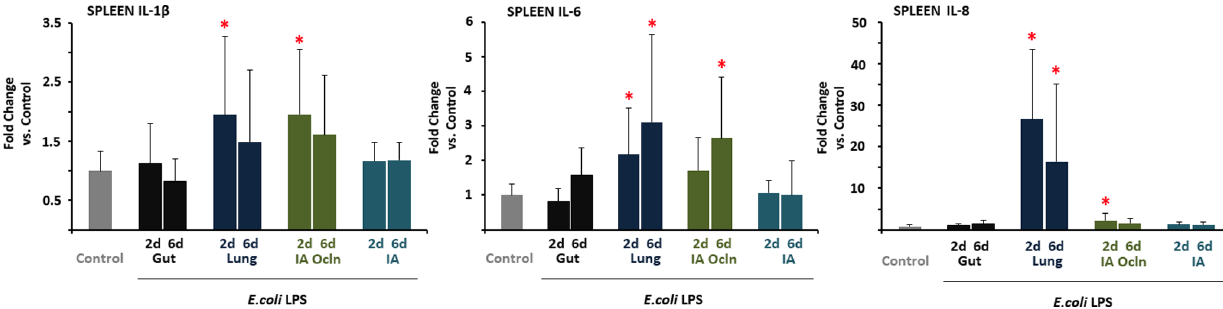
Figure 4. LPS infusion in the lung or the amniotic fluid induced spleen cytokine expression. Quantification of messenger RNAs for (A) IL- 1 b , (B) IL-6, (C) IL-8, was performed by real-time PCR assays using sheep-specific primers and hydrolysis probes. Each cytokine was normalized to 18s ribosomal protein mRNA (internal control), and levels for each group were expressed relative to controls as fold increase relative to controls. Cytokine expression increased in the ‘‘Lung’’ and the ‘‘IA Ocln’’ LPS groups. (* p , 0.0125 vs. control for IL-6 and IL-8, p , 0.05 vs. control for IL-1 b ).